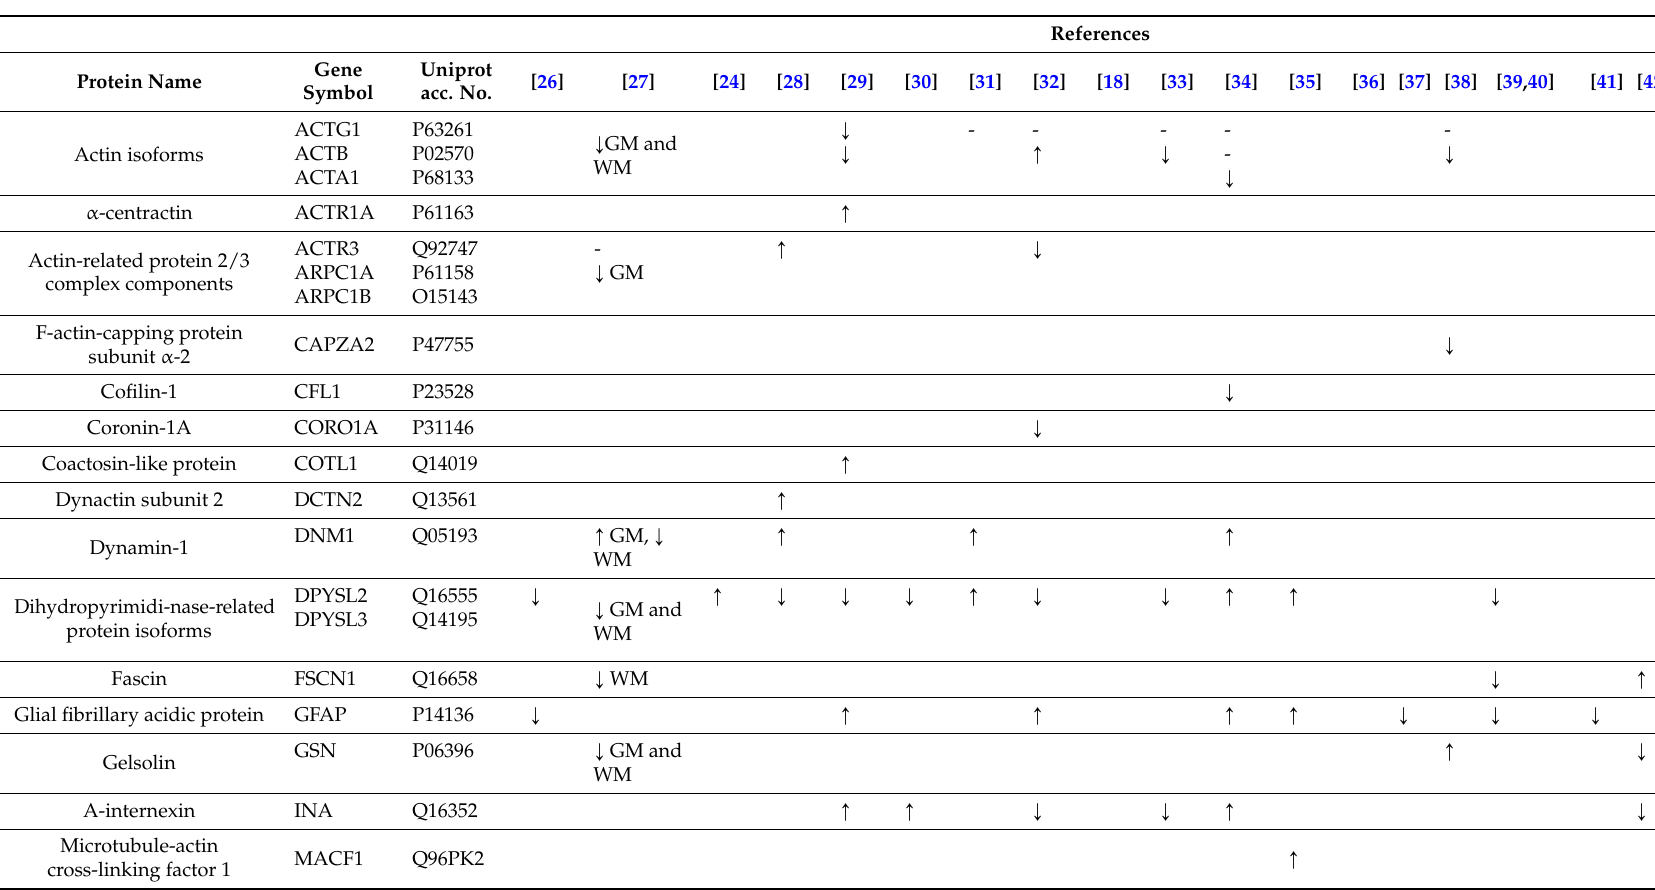
Table 1. Summary of the proteins altered expression from postmortem proteomic investigations of Schizophrenia. Gray matter (GM), white matter (WM), downregulated ( Ó ), upregulated ( Ò